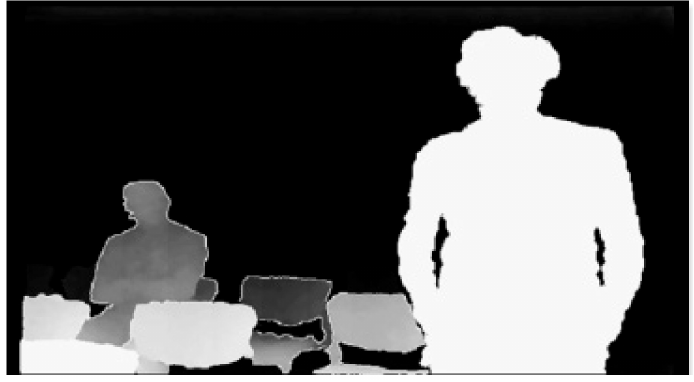
Figure 4. A VA-ST Smart Specs captured image.